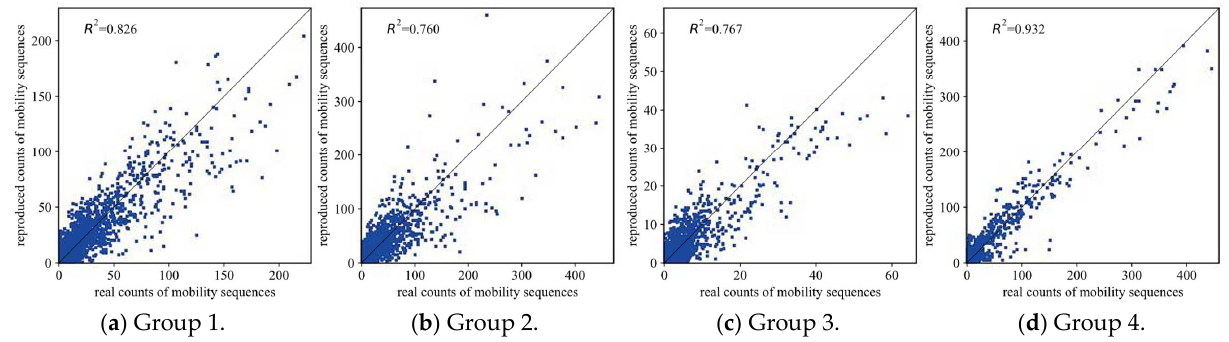
Figure 12. Spatiotemporal evaluation for each group for 2008. ( a ) Evaluation for Group 1; ( b ) Eval ‐ uation for Group 2; ( c ) Evaluation for Group 3; ( d ) Evaluation for Group 4. tion for Group 2; ( c ) Evaluation for Group 3; ( d ) Evaluation for Group